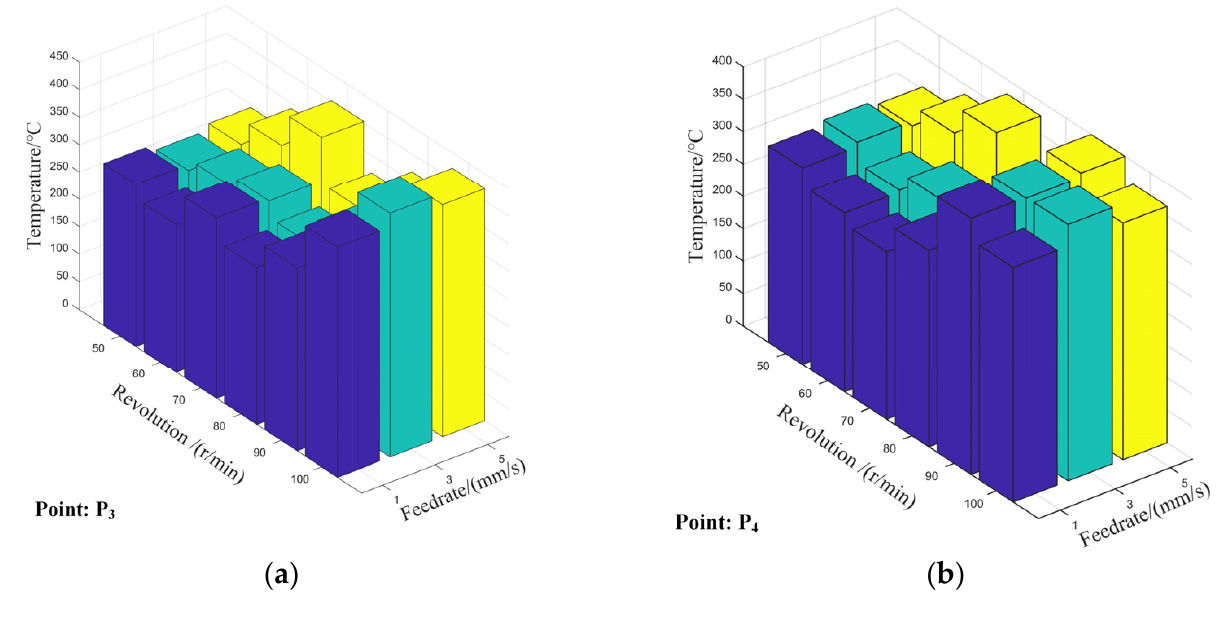
Figure 20. Temperature of tracking points P 3 and P 4 under different process parameters. ( a ) point P 3 ; ( b ) point P 4 .